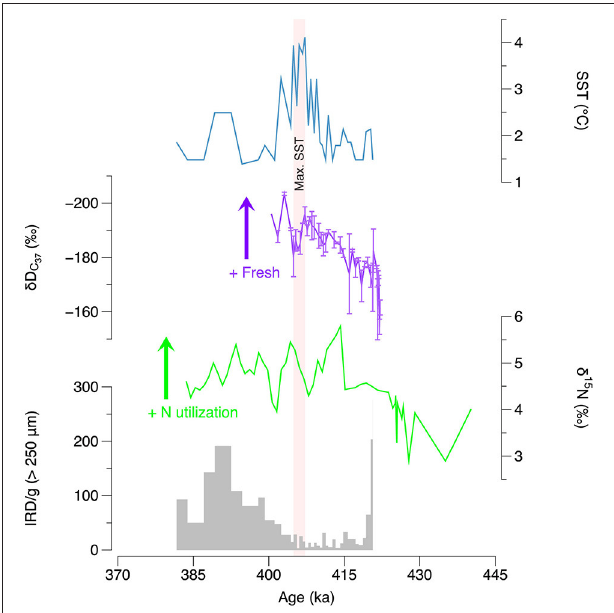
FIGURE 6 | Freshwater input and upper-ocean structure. (Top to bottom) SST, hydrogen composition of C 37 alkenones and their standard deviations ( Kandiano et al., 2016), stable nitrogen isotope signal of host-sediment nitrate (Thibodeau et al., 2017a, and > 250 µ m IRD/g (Helmke et al., 2003; Kandiano et al., 2012 ). Temperature optima are highlighted by the vertical shaded region.